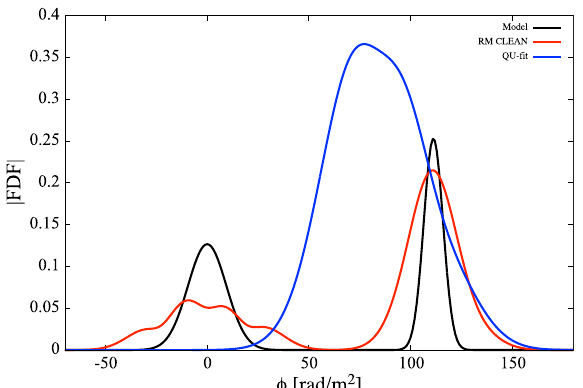
Figure 4. The reconstructed FDF by QU-fitting (blue line) of the w2g4 source model, cleaned FDF (red line) constructed by RM CLEAN using the same simulation data of QU-fitting, and the source model FDF (black line).